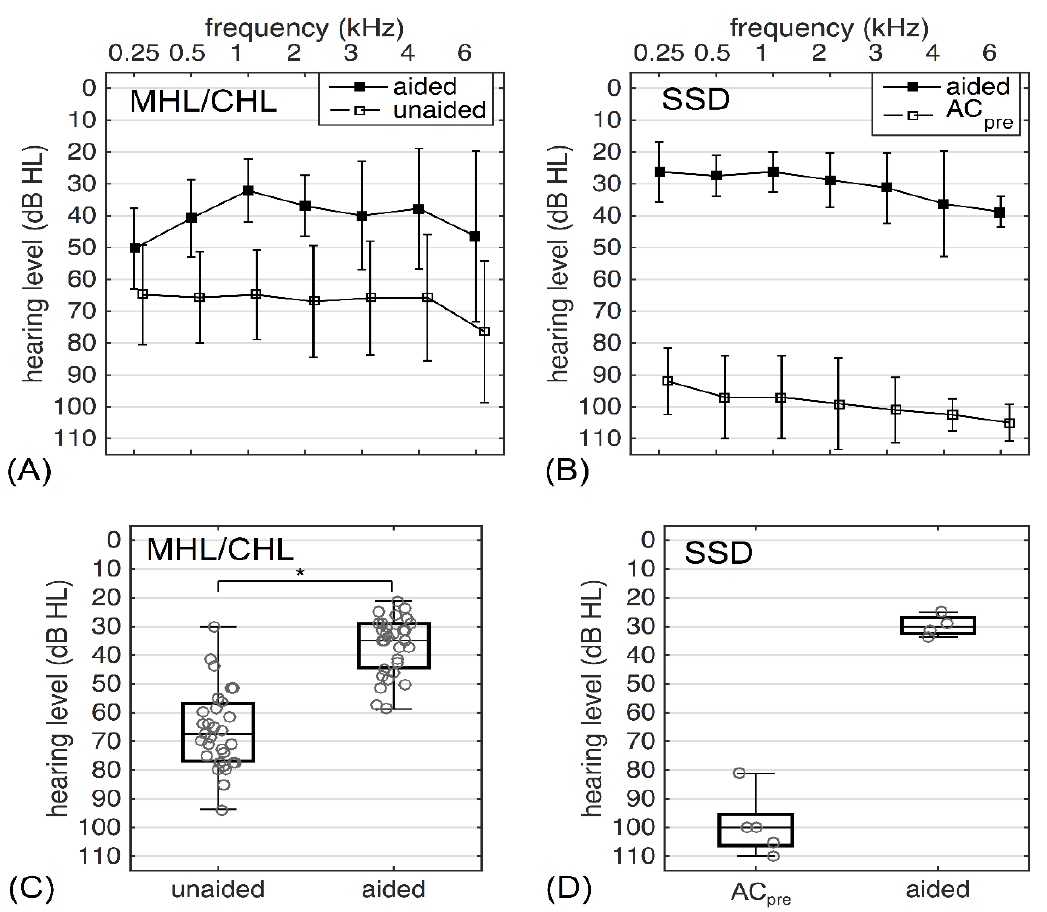
Figure 3. Hearing performance with and without the implant. ( A ) Average aided and unaided sound field thresholds for patients with CHL/MHL; ( B ) average aided sound field threshold and the preoperative AC threshold for SSD patients. Error bars indicate the standard deviation around the mean. ( C , D ) PTA 4 defined as the average of thresholds at 0.5, 1, 2, and 4 kHz for CHL/MHL and SSD patients. Grey circles indicate individual data. * p < 0.0001 .